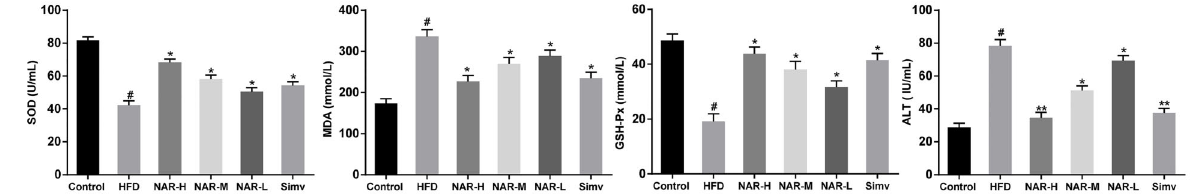
Figure 2. NAR decreased oxidative damage in HFD-induced atherosclerosis ApoE – / – mice. Data are reported as mean ± SD. # P o 0.01, *P o 0.05, compared to the control group; **P o 0.01, compared to the HFD group; n=8 (ANOVA). NAR: naringenin: high (H), medium (M), low (L); HFD: high-fat-diet; ApoE – / – : apolipoprotein E-knockout; Simv: simvastatin; SOD: superoxide dismutase; MDA: malondialdehyde; GSH-Px: glutathione peroxidase; ALT: alanine